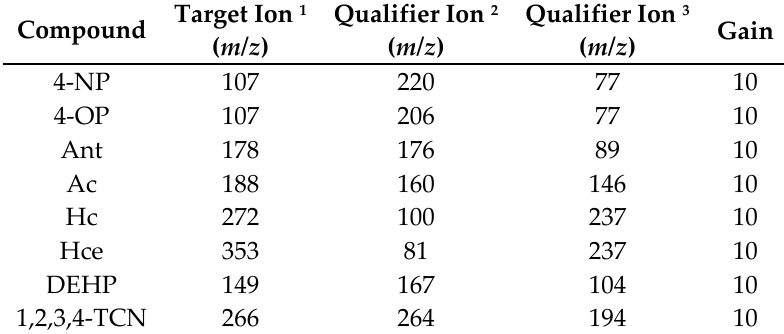
Table 1. Selected compounds fragments used in Selected Ion Monitoring detection operating